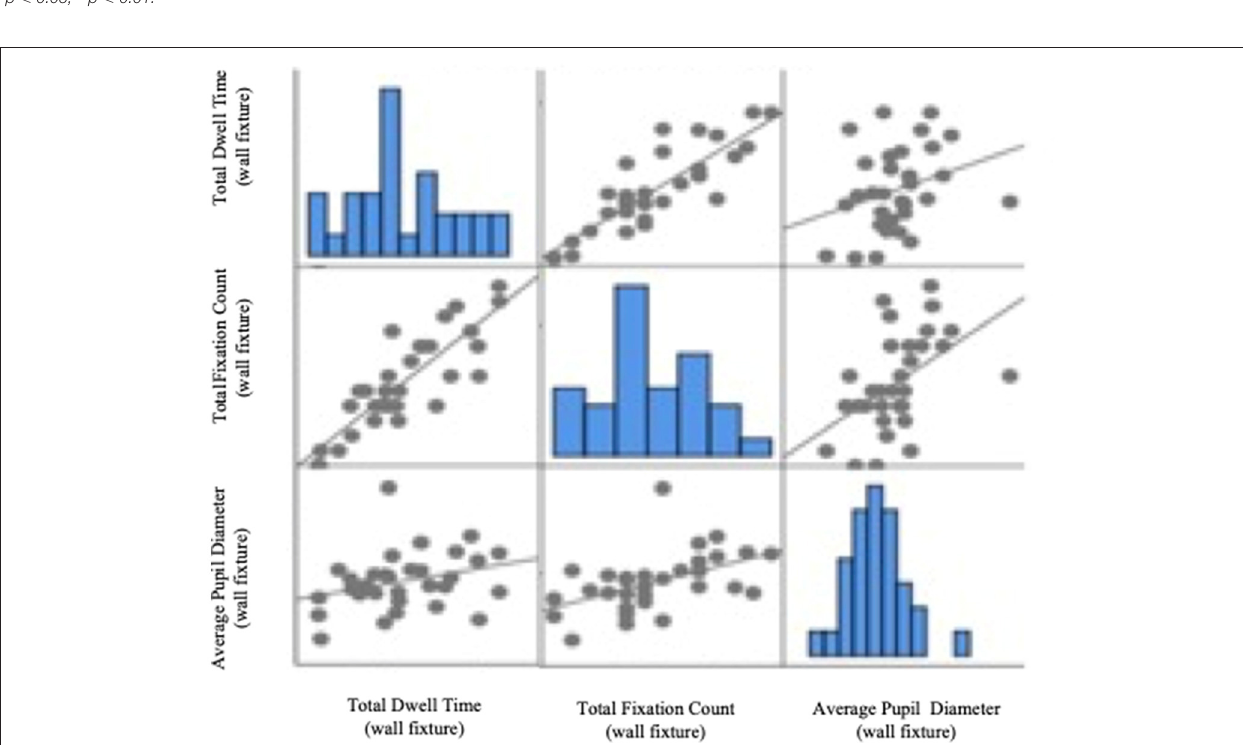
FIGURE 9 | Scatter plots of correlation analysis between visual attention and emotional